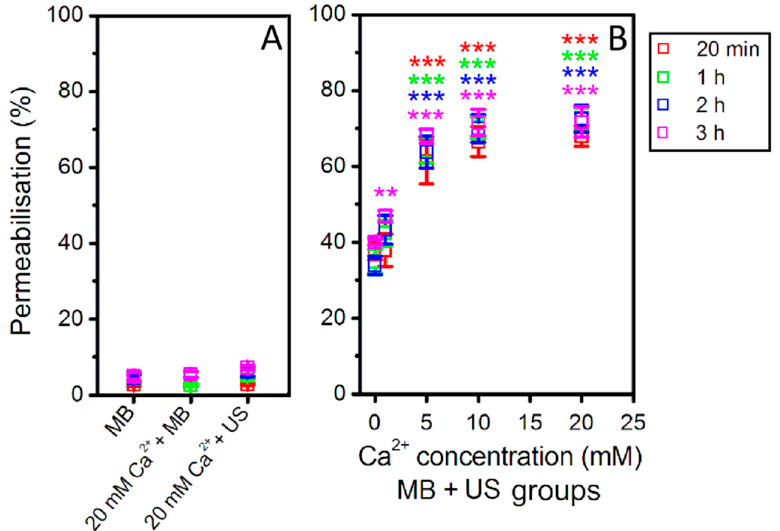
Figure 5. Cell membrane permeabilization (PI assay after 20 min–3 h), evaluated after US (400 kPa) treatment in the presence of MBs at different Ca 2+ concentration. (MB), (Ca 2+ + MB) and (Ca 2+ + US) experimental groups ( A ); (Ca 2+ + MB + US) experimental groups ( B ). ** p < 0.01, *** p < 0.001 indicate statistical significance between cavitation [(Ca 2+ + MB +US) at 0 mM Ca 2+ concentration] and therapeutic [(Ca 2+ + MB +US) at 1–20 mM Ca 2+ concentration] groups.